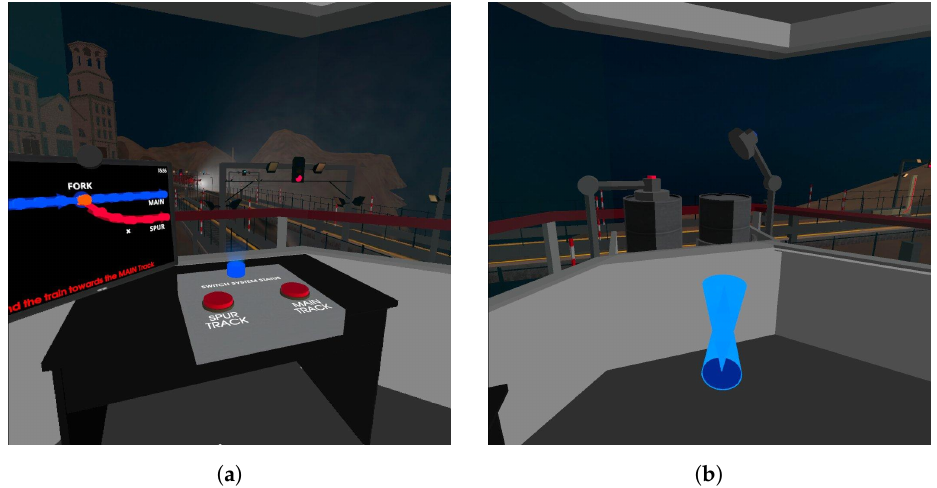
Figure 2. Training with safety systems. ( a ) A screen shows the main and the spur tracks. Here, the main track is live. Pressing buttons switches between tracks. ( b ) When the switch system fails, participants can push unlocked barrels to stop a train on the spur track.